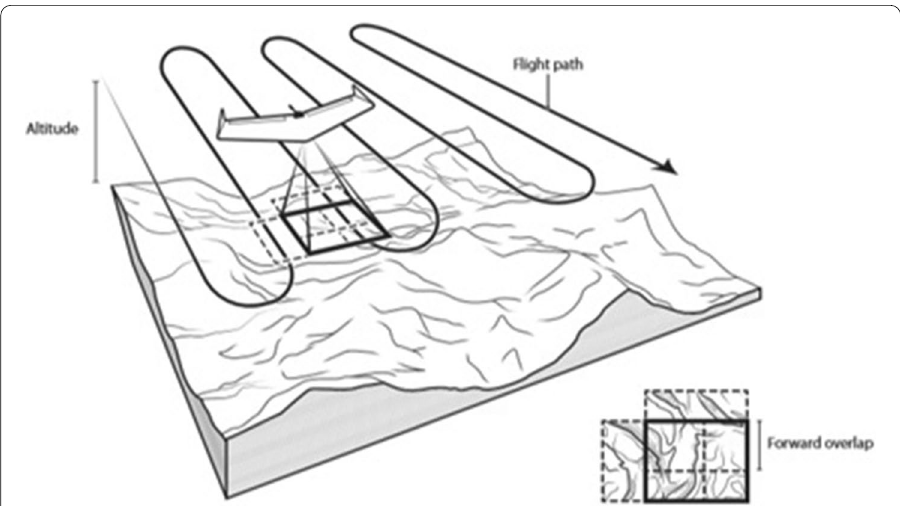
Fig. 2 The principle of drones doing the mapping. Mapping with UAVs / drones is designed to ensure adequate image type by overlapping images that are contiguous